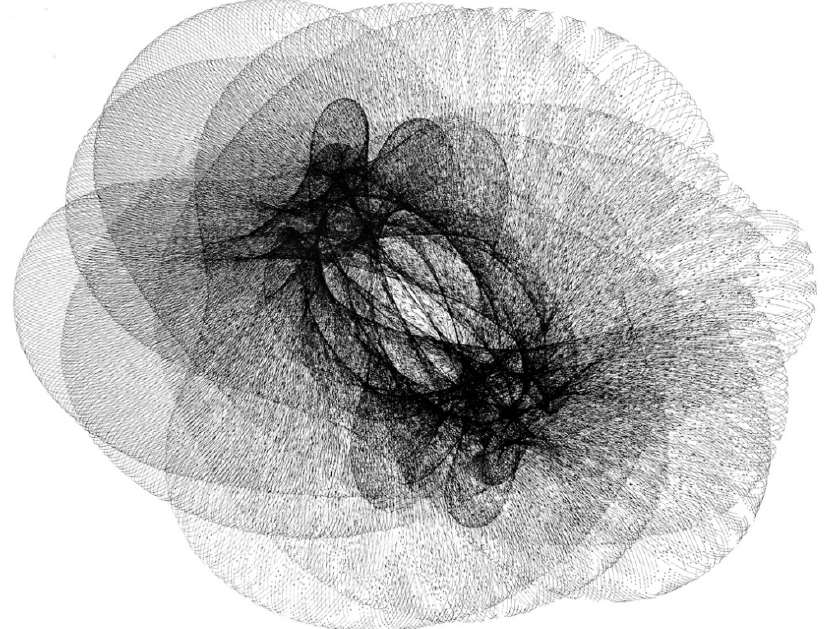
Figure 11. HHM drawing with pen ‐ lift.